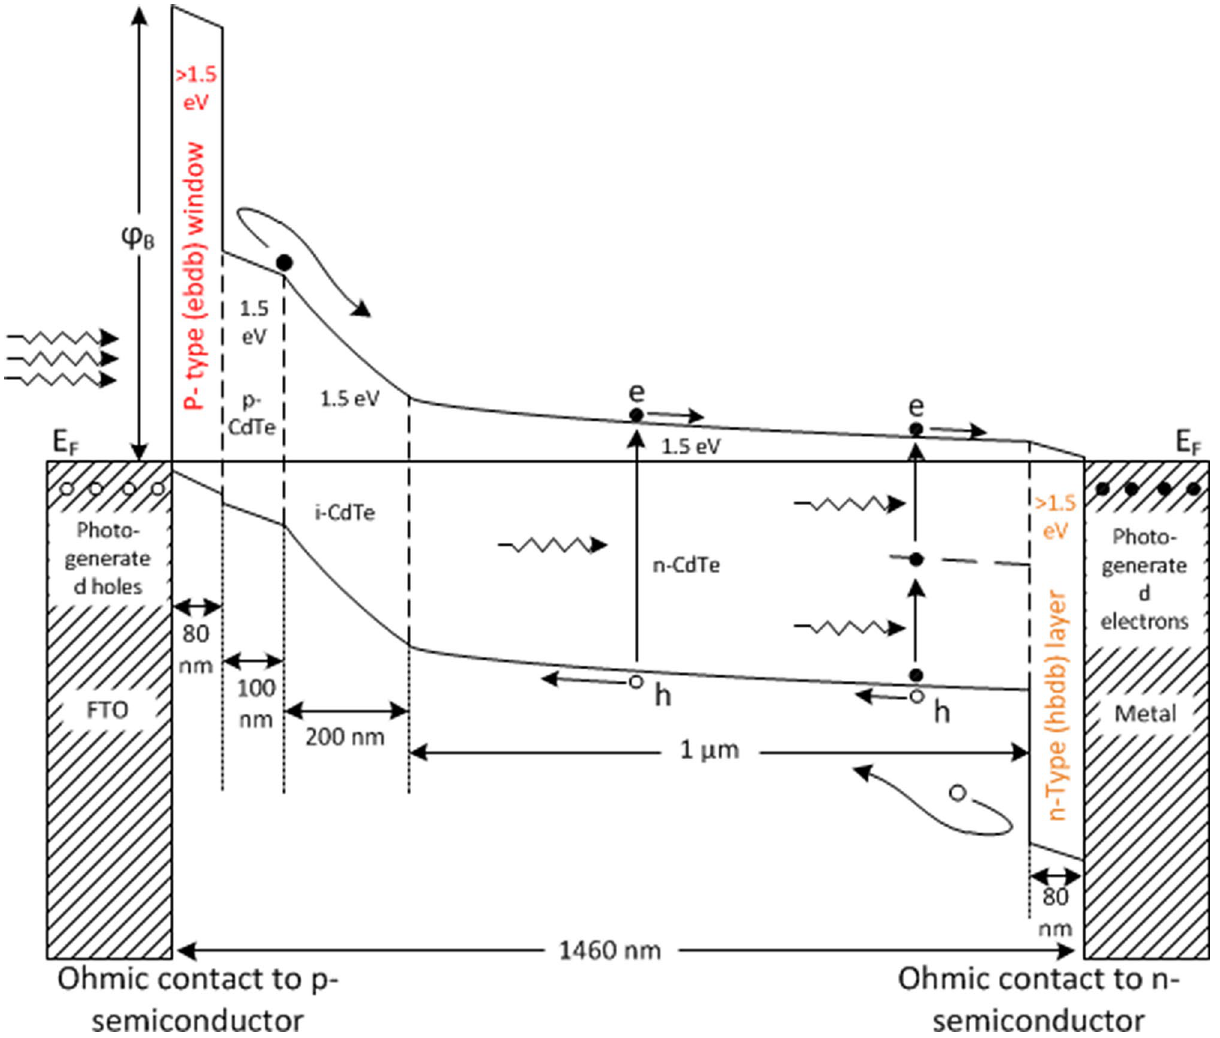
Figure 1. Energy band diagram drawn to scale for a short-circuited multi-layer solar cell based on p-type window material (p + -p-i-n–n + structure). P + and n + layers act as electron back diffusion barrier (ebdb) layer (or Hole Transport Layer- HTL), and hole back diffusion barrier (hbdb) layer (or Electron Transport Layer- ETL)